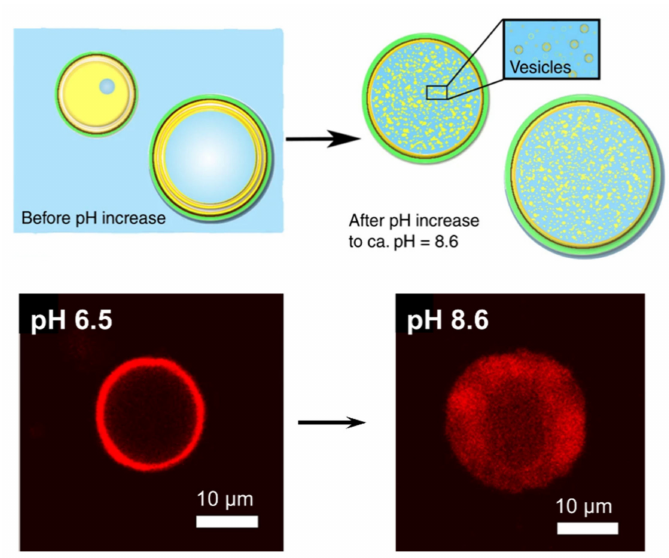
Figure 4. Proposed mechanism for the formation of vesicles in the microcapsule interior and CLSM images at pH 6.5 and pH 8.6. Adapted from ref. [137].